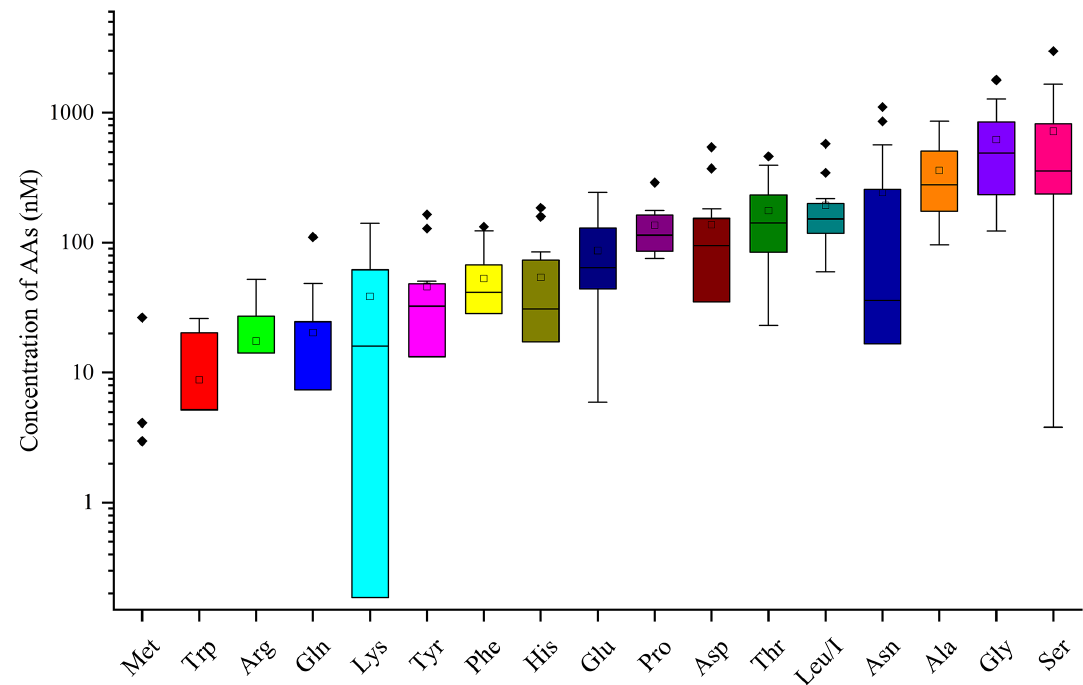
Figure 2. Distribution of each AA for the 13 cloud samples. AA concentrations are in logarithmic scale. The bottom and top lines of the box correspond to the 25th and 75th percentiles, respectively. The middle line represents the median value and the square the mean value. The ends of the whiskers are the 10th and 90th percentiles, and the filled diamonds are outliers (concentrations above the 90th percentile).